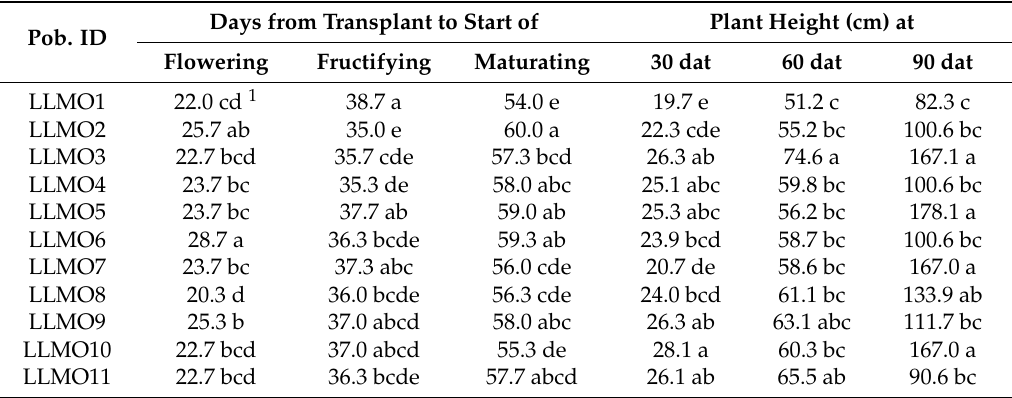
Table 3. Mean comparisons of days to start of flowering, fructifying and maturating of fruits, and plant height in eleven tomato accessions from El